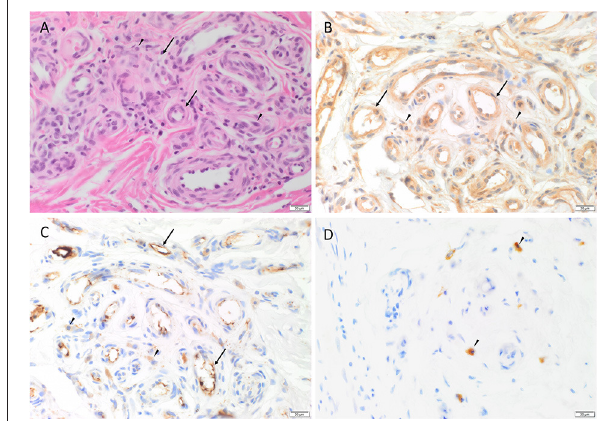
FIGURE 1 | Representative H&E and immunohistochemical staining of arterio-venous malformation (AVM) tissue samples. H&E staining demonstrated AVM nidus consisting a tangle of vessels of varying luminal diameter and wall thickness ( arrows ), surrounded by a fibrous stroma ( arrowheads ) (A) . Immunohistochemical staining showed cytoplasmic expression of cathepsin B ( B , brown), cathepsin D ( C , brown) within the endothelium ( arrows ) of the lesional vessels and cells within the stroma ( arrowheads ), and cytoplasmic expression of cathepsin G ( D , brown) in cells within the stroma ( arrowheads ). Nuclei were counterstained with hematoxylin ( B – D , blue). Original magnification :